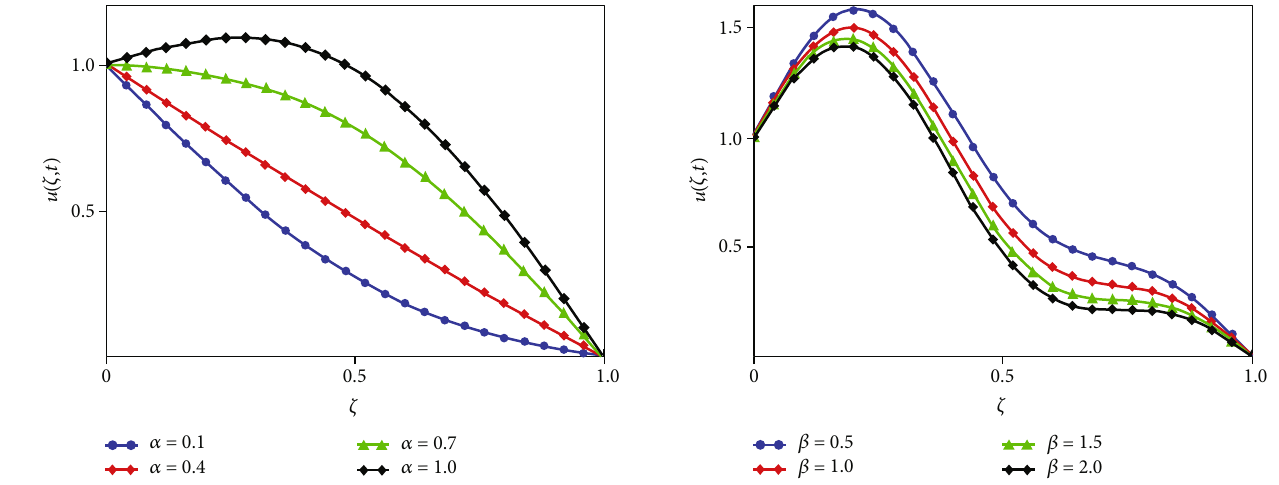
Figure 2: In fl uence of several values of α on velocity pro fi le. Figure 3: Impact of di ff erent values of β on velocity pro fi le.